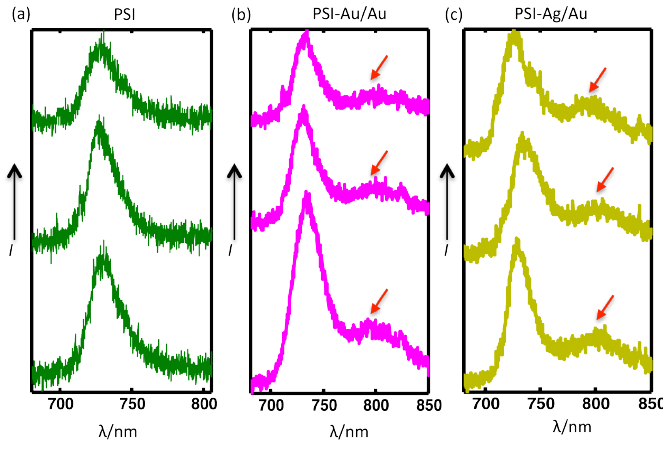
Figure 6. Comparison of three individual datasets from three single complexes of each ( a ) PSI-glass ( b ) PSI-Au/Au and ( c ) PSI-Ag/Au. The red arrows point to the